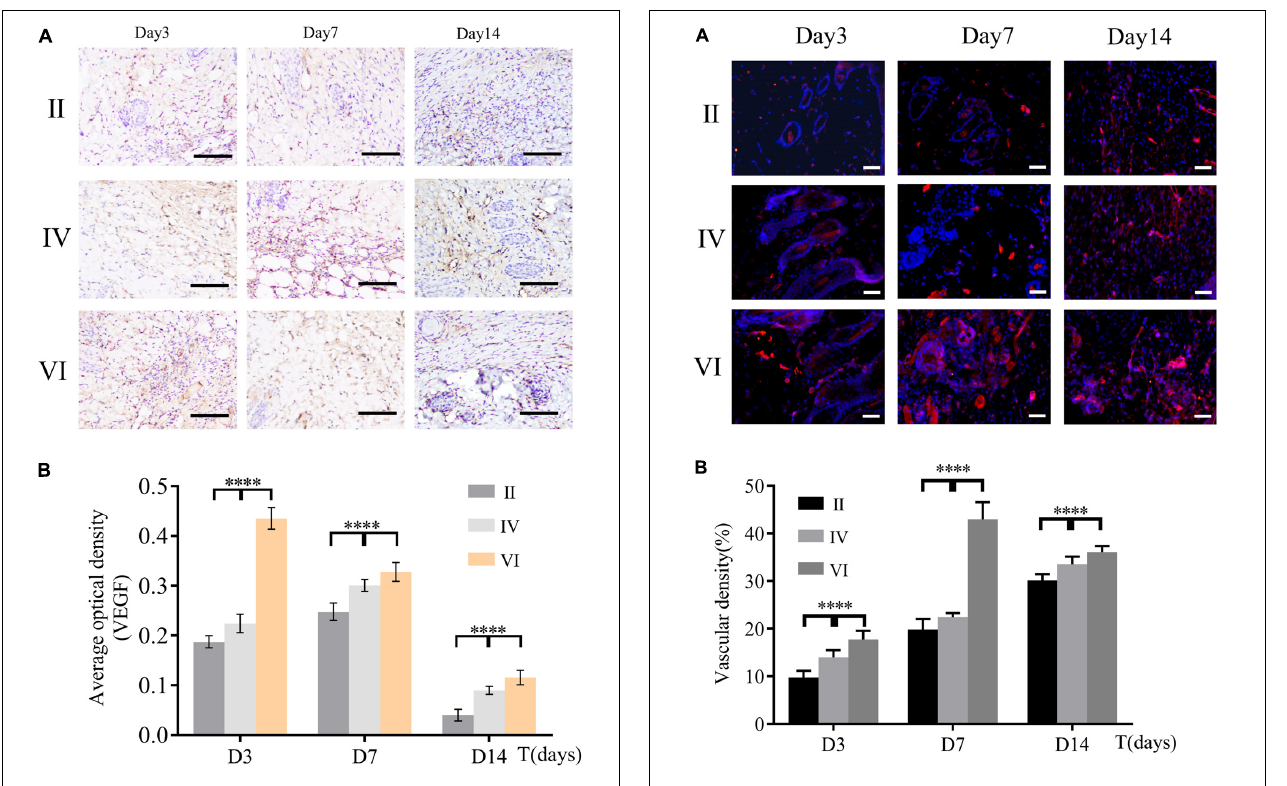
FIGURE 9 | (A) Immunohistochemical staining for angiogenic factor VEGF of the wound tissues during the healing at different days (3, 7, and 14). Scale bar, 200 µ m. (B) The average optional density was calculated by ImageJ. ( n = 6, data = mean ± SD.) (II: NIR; IV: HA hydrogel + NIR; and VI: CuS/HA hydrogel + NIR).